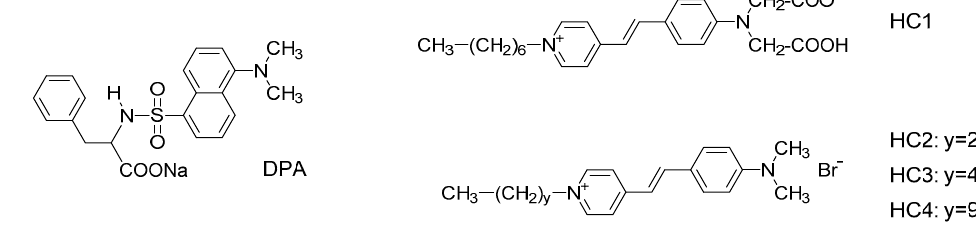
Figure 9. Chemical structure of the solvatochromic fluorescent dyes used in solubilization studies.